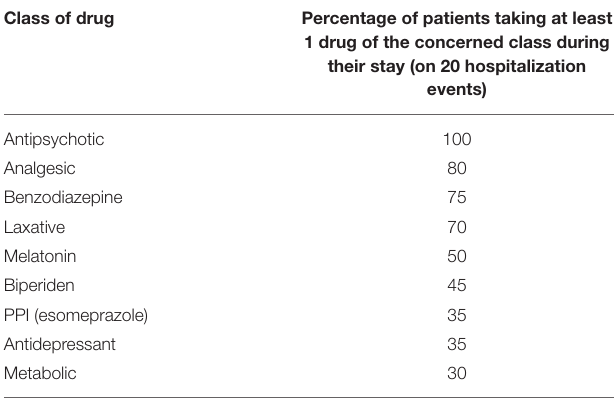
TABLE 5 | Percentage of patients taking at least one of the drugs of the listed drug classes during their stay (on 20 hospitalization